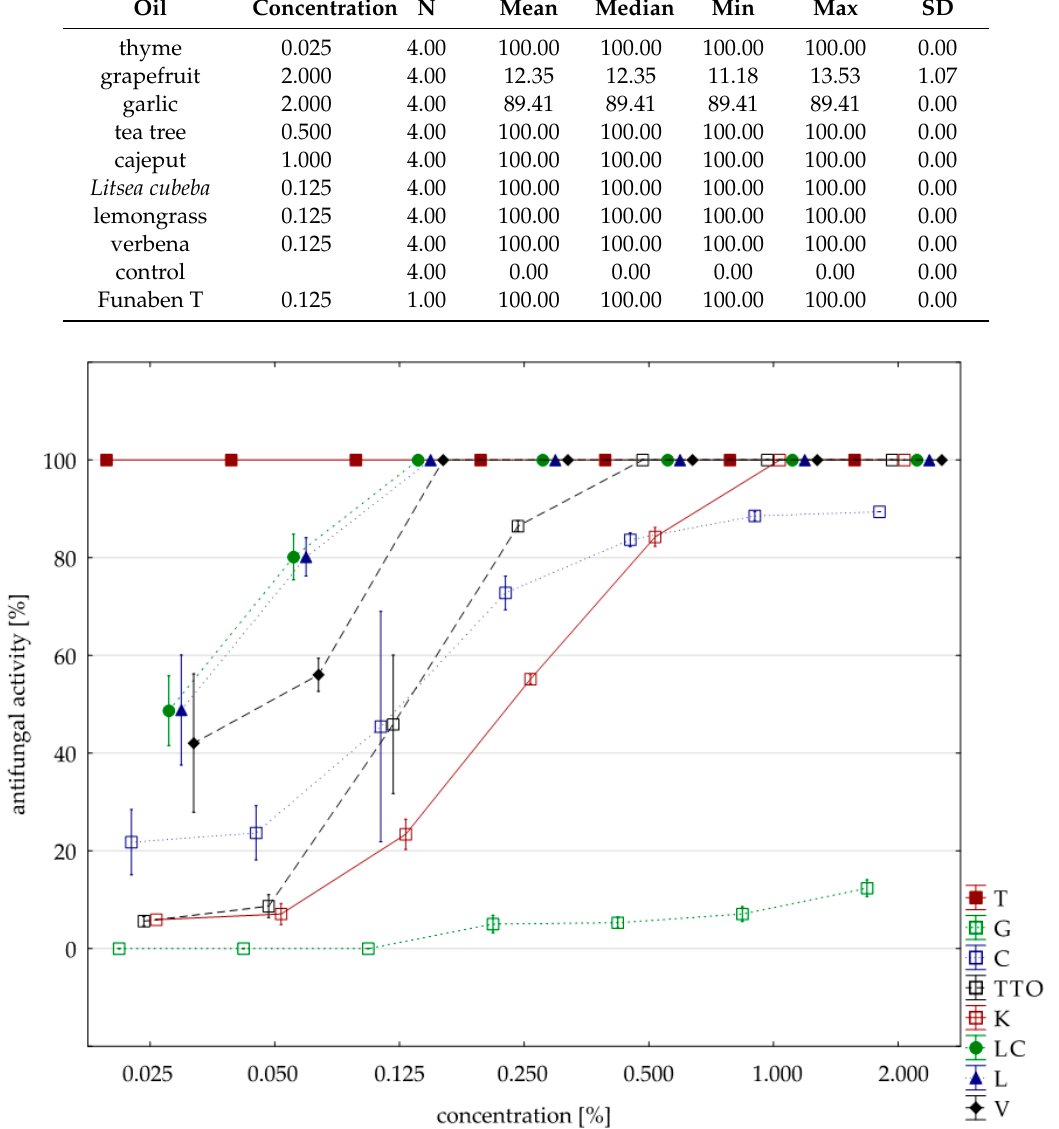
Table 7. Maximum fungistatic activity of the analyzed oils at minimum concentration for the isolate of F. avenaceum .